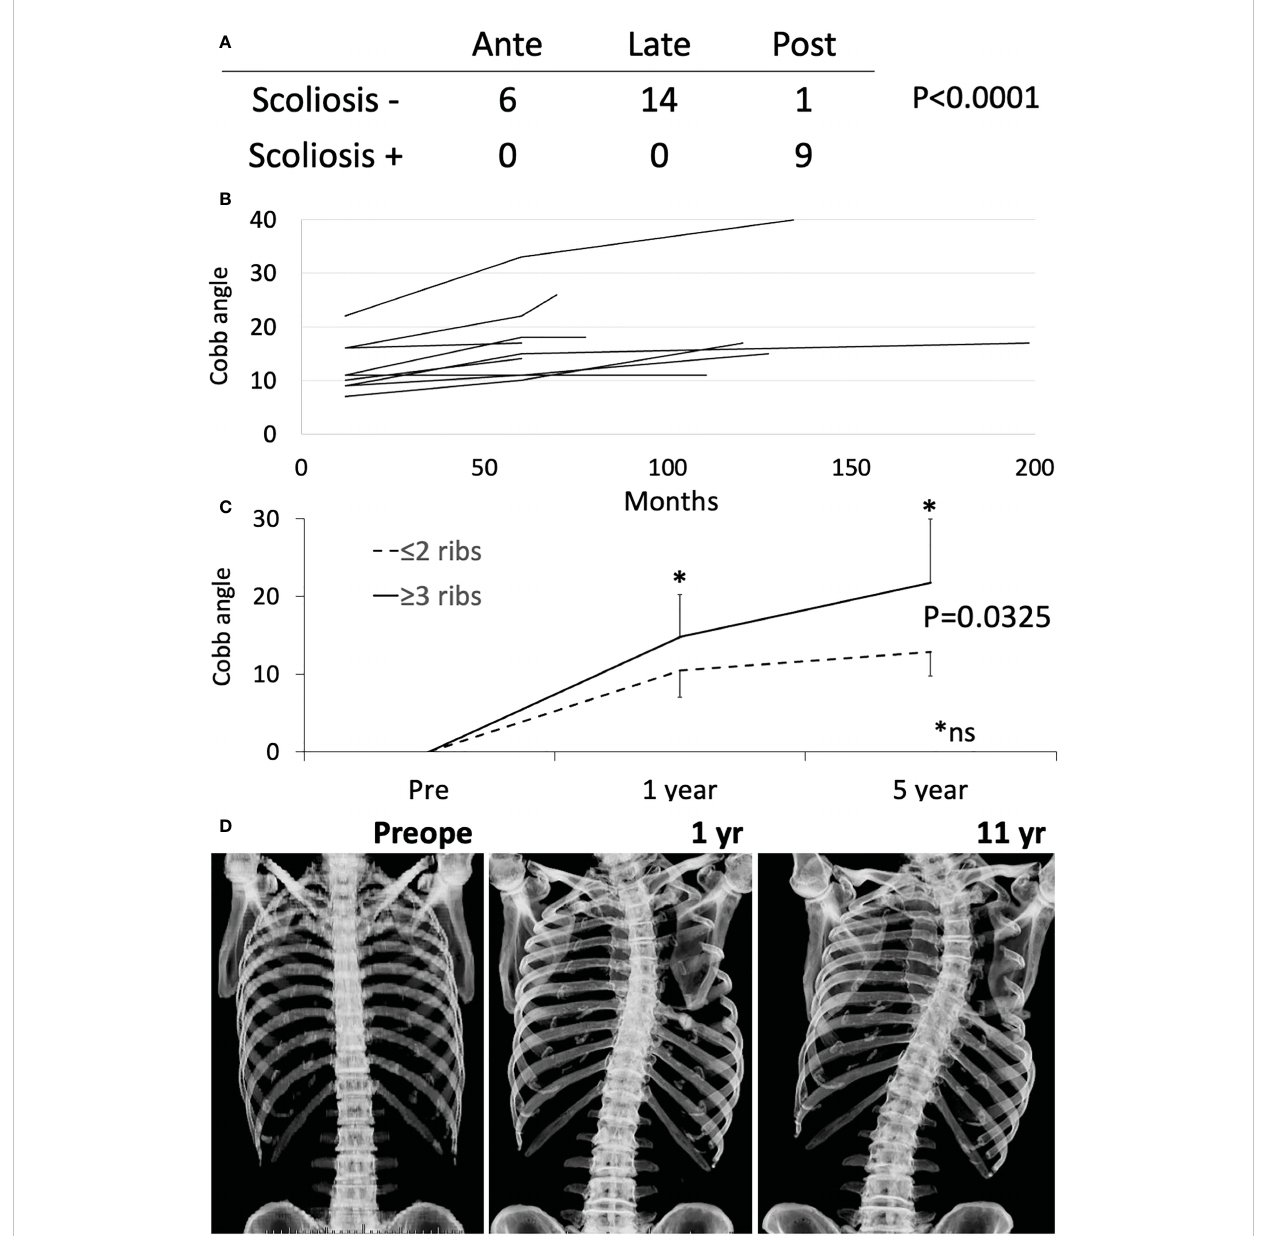
FIGURE 3 Scoliosis analysis. (A) Fisher exact test was performed between anterior (Ante), lateral (Late) and posterior (Post) resection with or without scoliosis. (B) Cobb angle at 1 year, 5 years, and at last follow-up was shown by the line chart. (C) The time-dependent changes of cobb angle were shown between groups with resection of ≤ 2 ribs and ≥ 3 ribs. The time-dependent analysis showed signi fi cant difference by repeated-ANOVA (p=0.0325). * Mann-Whitney test at 1 year and 5 year time point was not signi fi cant (ns). (D) Chest Xray of a representative case is